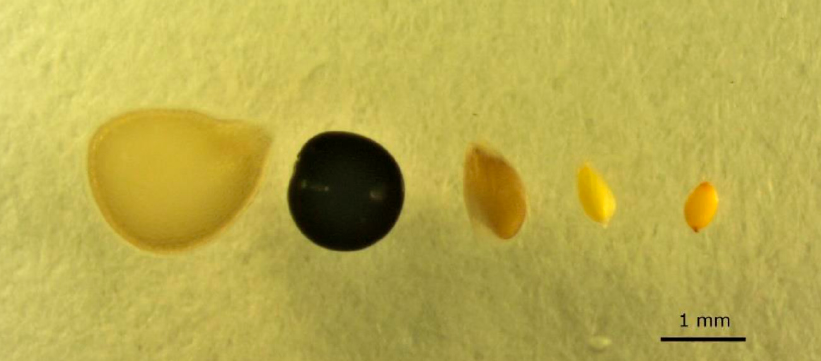
Figure 4. Seeds of the five weed species fed to lesser black-backed gulls, in order of decreasing seed size. From the left to the right: Solanum nigrum , Amaranthus retroflexus , Polypogon monspeliensis , Cyperus difformis and Juncus bufonius . Dispersal syndromes according to [75] are: S. nigrum endozoochory, A. retroflexus barochory, and the other three epizoochory.